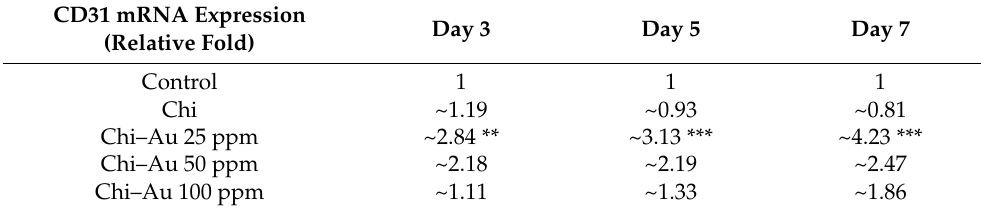
Table 4. CD31 mRNA expression at 3, 5, and 7 days.